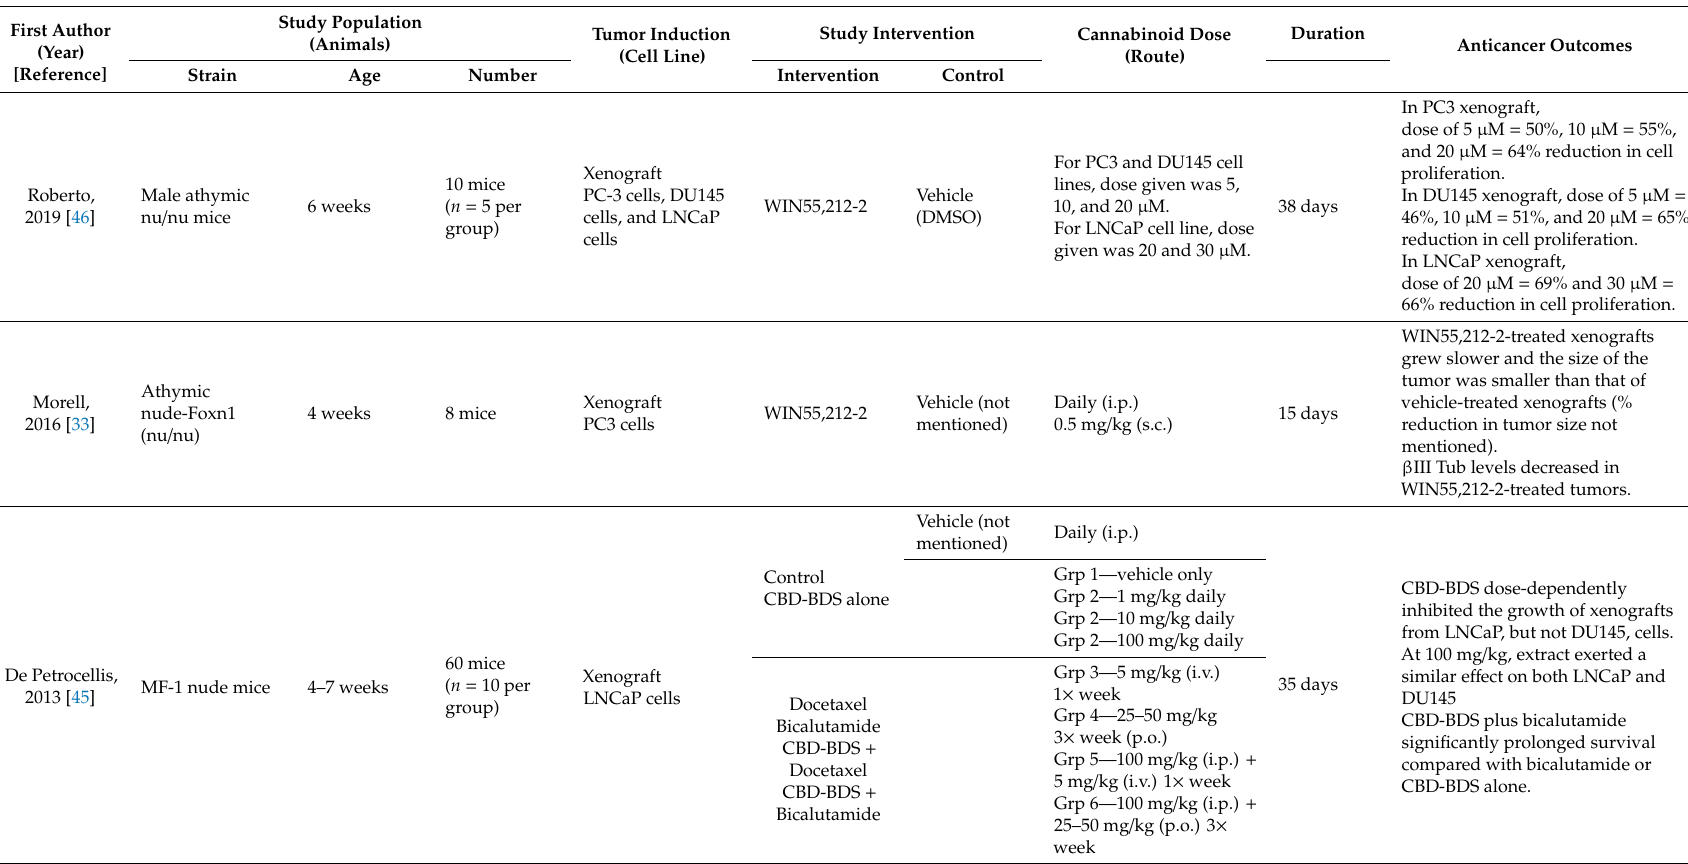
Table 2. Characteristics of the in vivo identified studies. All of these studies were performed in male animal